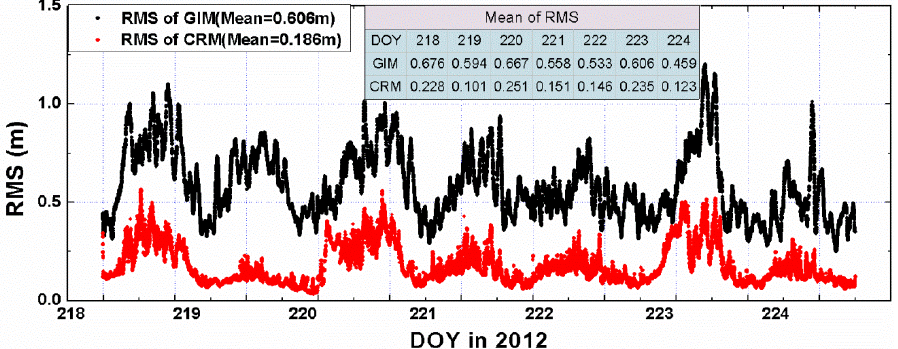
Figure 8. RMS of the residuals of the interpolated slant delays from GIM (black) and CRM (red) with respect to the reference slant